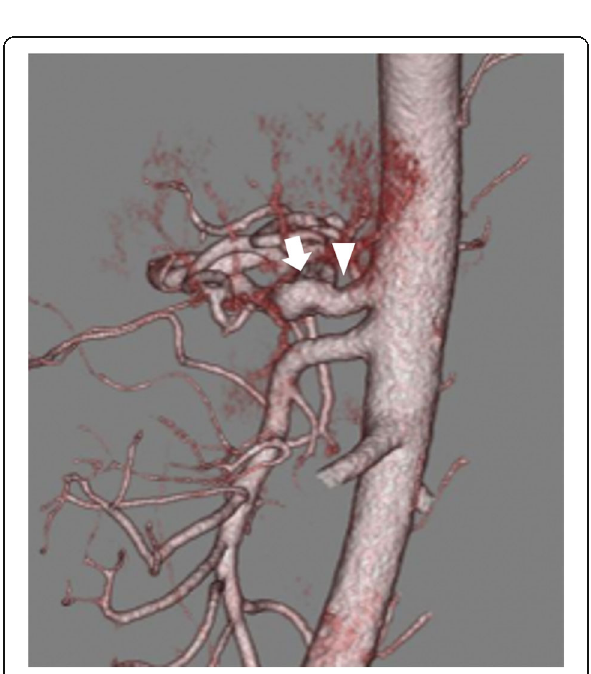
Fig. 3 Follow-up (6 months) 3D aortic reconstruction showing a normal caliber of the celiac artery, without evidence of stenosis (arrow head) or poststenotic dilatation